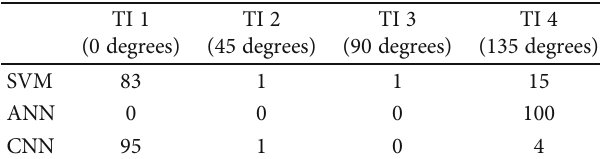
Table 7: TI rejection based on the probability of TI in Table 6 to regenerate 100 models.